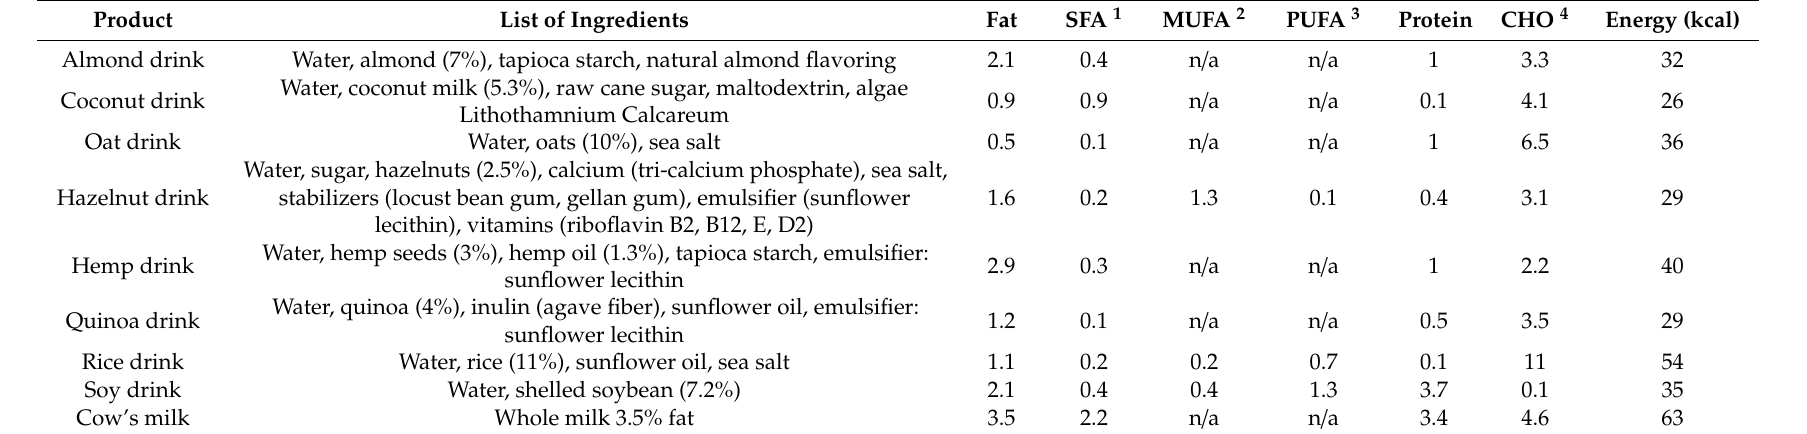
Table 1. Nutritional composition of the samples as stated on the package labeling in g · (100 mL) − 1